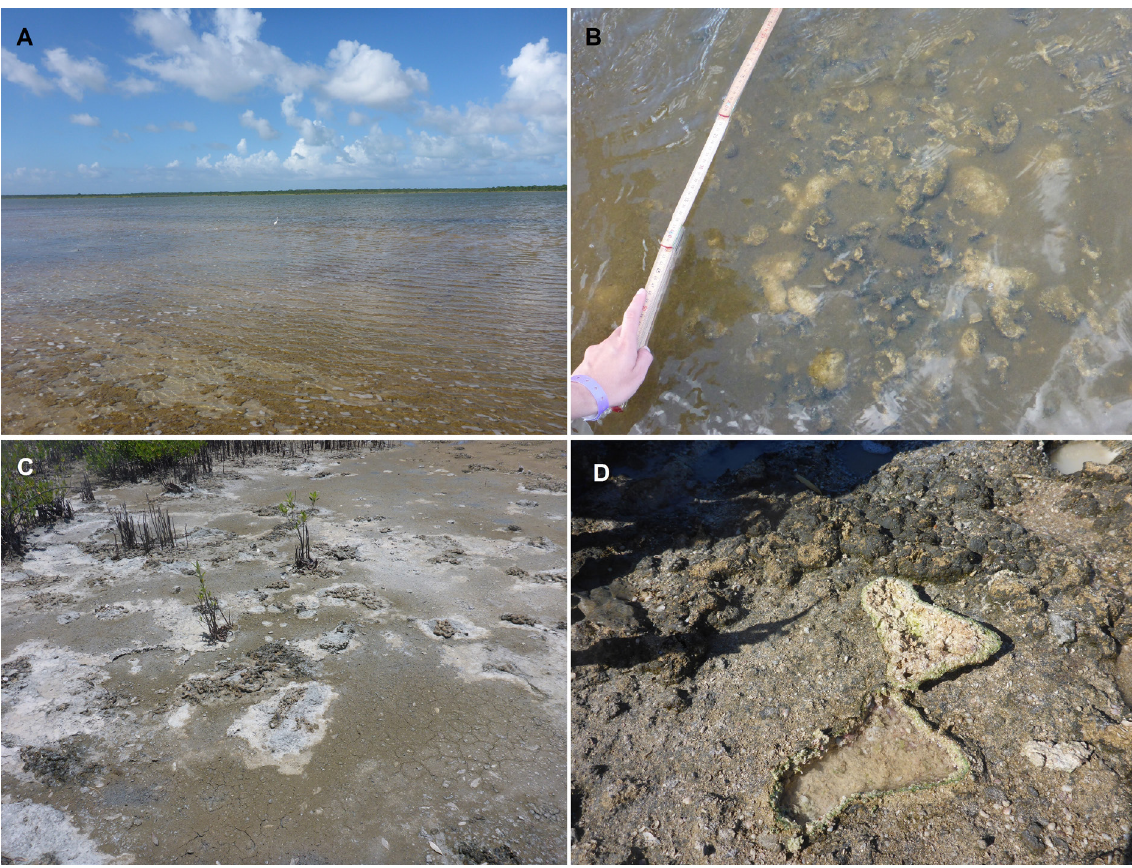
Figure 4. The stromatolites of El Jato Lagoon. A) Partial view of El Jato Lagoon with submerged stromatolites. B) Submerged stromatolites. C) Partial view of desiccated zones in El Jato Lagoon with exposed stromatolites. D) Exposed stromatolites. (Pictures are courtesy of Dr. Emmanuelle